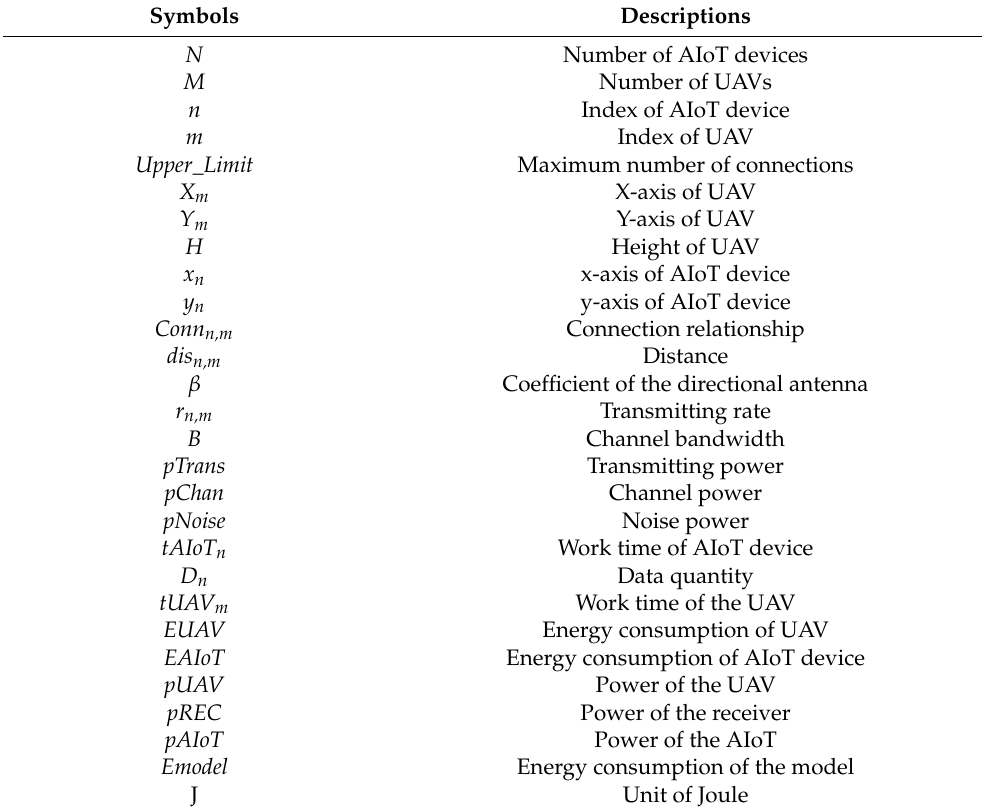
Table A1. Summary of all the symbols in the mathematical problem model.